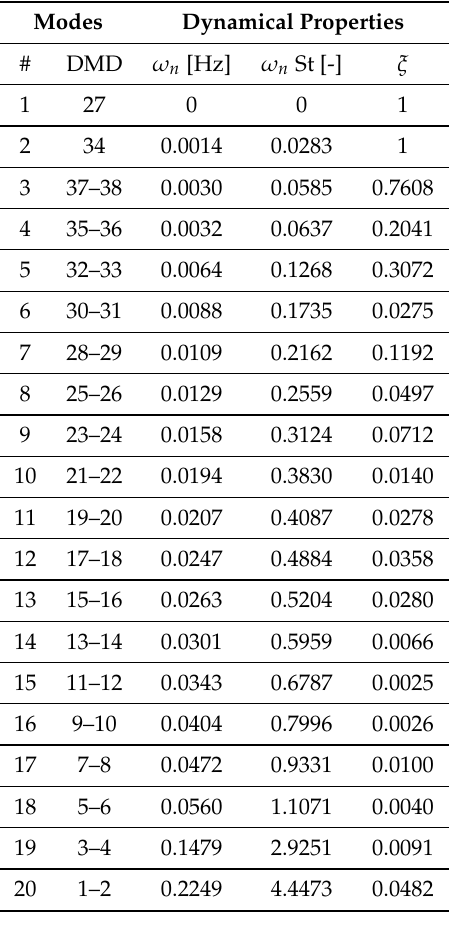
Table 2. Dynamical properties of IODMD u model. The first column entries corresponds to the numerology chosen for the modes, which are ordered by increasing natural frequency. The second column entries correspond to their order in terms of eigenvectors of state matrix ˜ A . The third and fourth columns have information of the modes natural frequencies and fifth column the damping ratio.